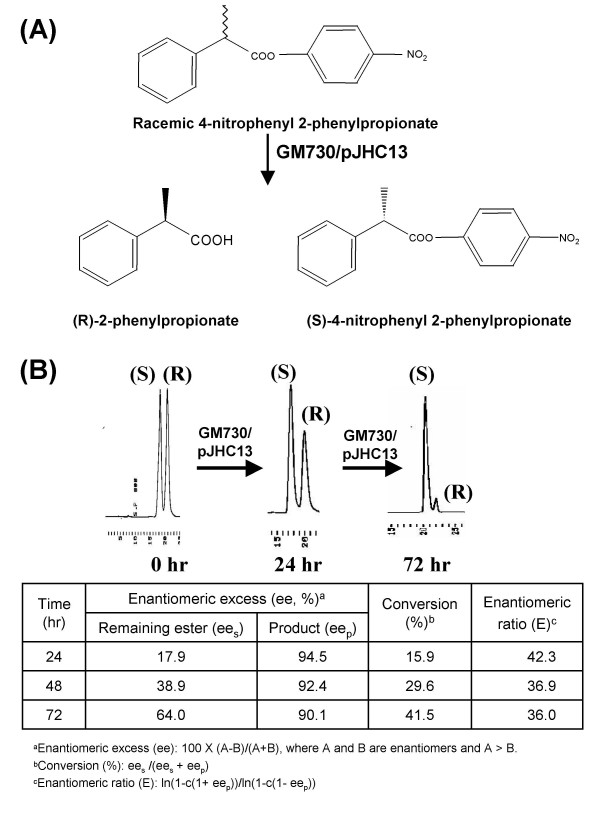
Chiral resolution of racemic 4-nitrophenyl 2-phenylpropionate (NPPP) in two-phase water-isooctane reaction system. (A) Schematic diagram for chiral resolution of NPPP. (B) Chromatograms and time dependence of reaction by P. putida GM730/pJHC13 cells over 72 h.